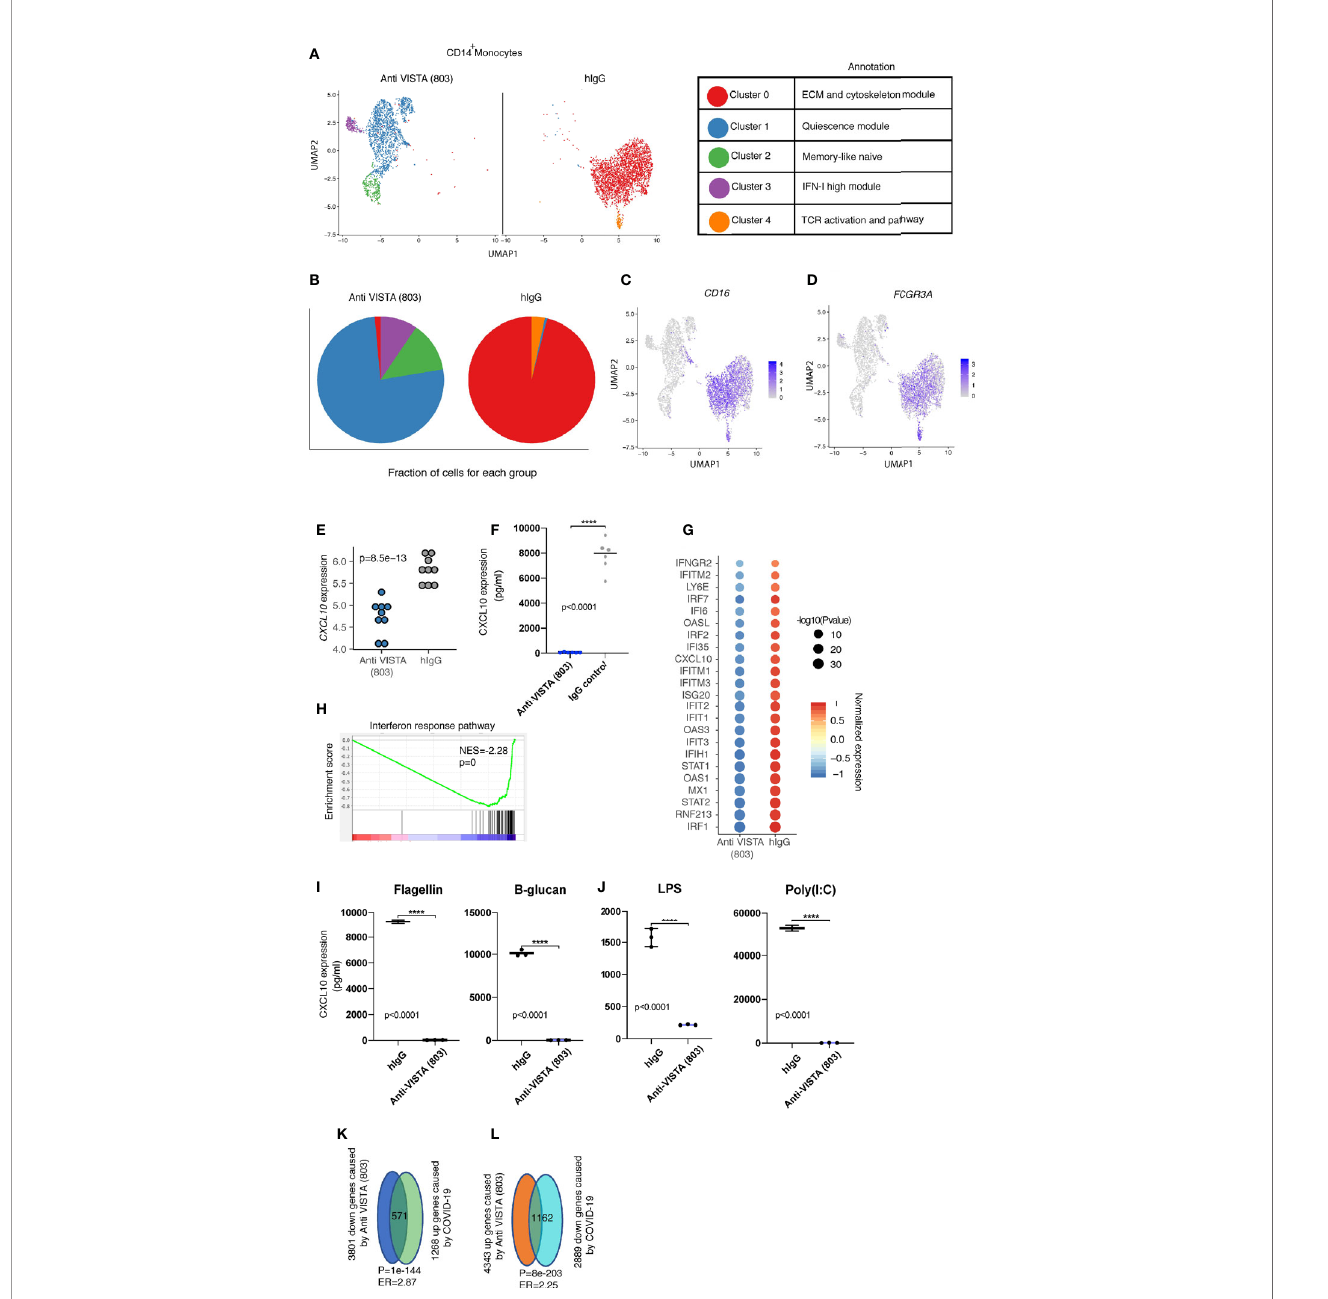
FIGURE 2 | Anti-VISTA agonist strikingly changes the CD14 + monocyte state and induces novel archetypes associated with the anti-in fl ammatory phenotype. (A) Uniform manifold approximation and projection (UMAP) plot showing the cluster distribution of Anti-VISTA (803) and hIgG2 isotype control treated CD14 + human monocytes. The biological annotation of each cluster is presented in the table on the right. (B) Pie chart indicating the composition of cluster difference in Anit-VISTA (803) and hIgG treated CD14+ human monocytes. (C, D) Feature plot showing the expression of Cd14 and Fcgr3a across different clusters in Anti-VISTA (803) and hIgG treated CD14 + human monocytes. (E) Dot plot depicting the CD14 gene expression difference between Anti-VISTA (803) and hIgG2 isotype control treated CD14 + human monocytes. (F) Human CD14 + monocytes were either treated with anti-VISTA agonist or hIgG2 isotype control for 24 h and CXCL10 supernatant levels was determined via multiplex analysis (G) Dot plot showing the interferon response associated genes difference between Anti-VISTA (803) and hIgG2 isotype treated CD14 + human monocytes. (H) GSEA plot showing the enrichment of interferon response pathway between Anti-VISTA (803) and hIgG2 treated CD14+ human monocytes. (I, J) Supernatant levels of CXCL10 determined by multiplex analysis after anti-VISTA agonist or control hIgG2 treatment of monocytes in the presence of Flagellin, B-glucan, LPS or Poly(I:C). (K, L) The Venn diagram showing the signi fi cant enrichment between Anti-VISTA (803) treated and COVID-19 CD14+ human monocytes. These experiments are representative of three independent repeat. ****p <